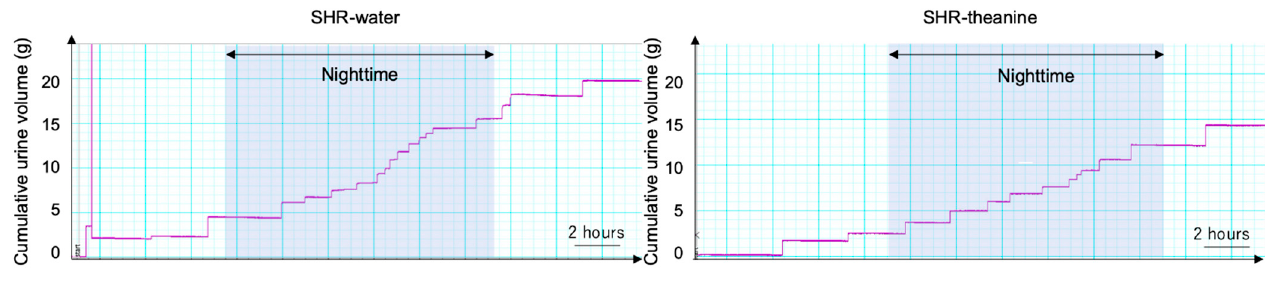
Figure 2. Typical 24 h voiding behavior by metabolic cage in the SHR–water and SHR–theanine groups. Gray shading represents nighttime. Scale bars = 2 h.